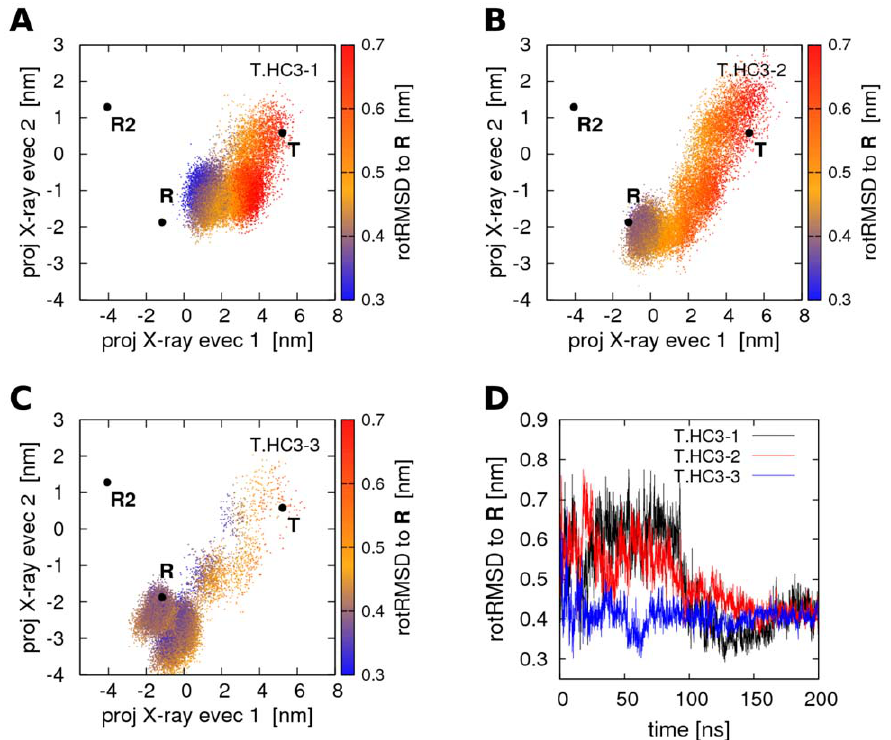
Figure 3. Quaternary T R R transitions in Hb simulations with protonated His( b )146. (A–C) Projections of Hb structures during simulations T.HC3-1 to T.HC3-3 on the two eigenvectors derived from a PCA of the T , R , and R2 X-ray structures. The color encodes the rotRMSD to the R X-ray structure. Full quaternary transitions of Hb occur during simulation time. (D) rotRMSD of simulations T.HC3-1 to T.HC3-3 to the R X-ray structure.